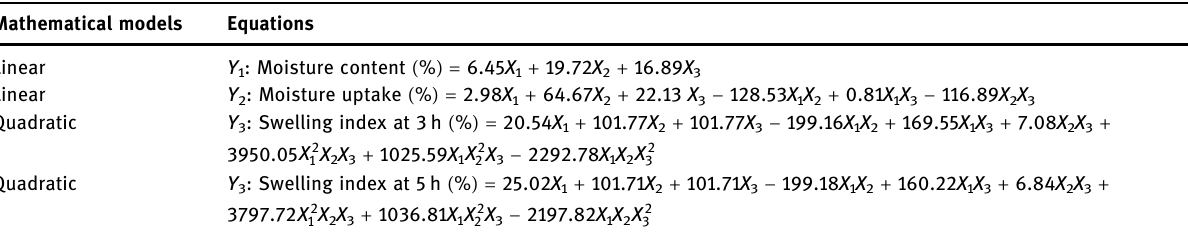
Table 2: Mathematical models and actual equations Mathematical models